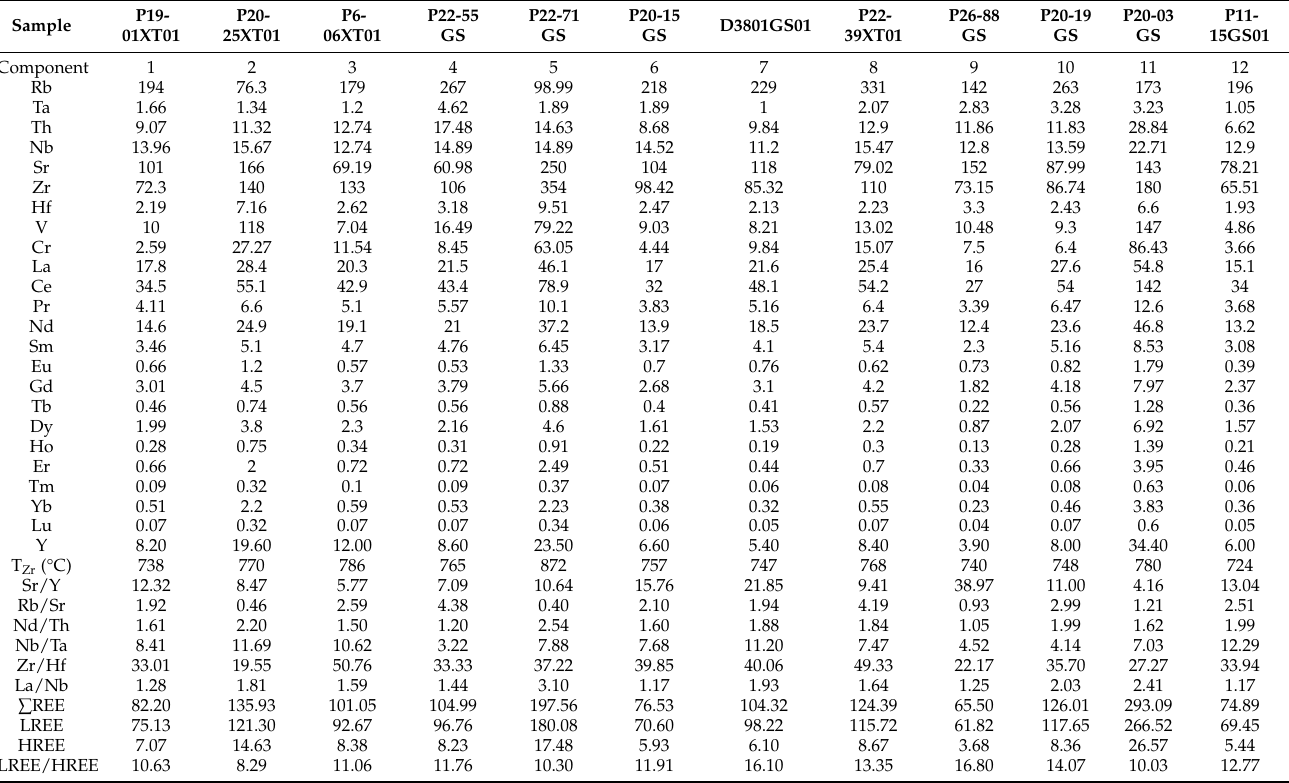
Table 2. Trace ( × 10 − 6 ) and rare earth element ( × 10 − 6 ) contents of Dahongliutan granite